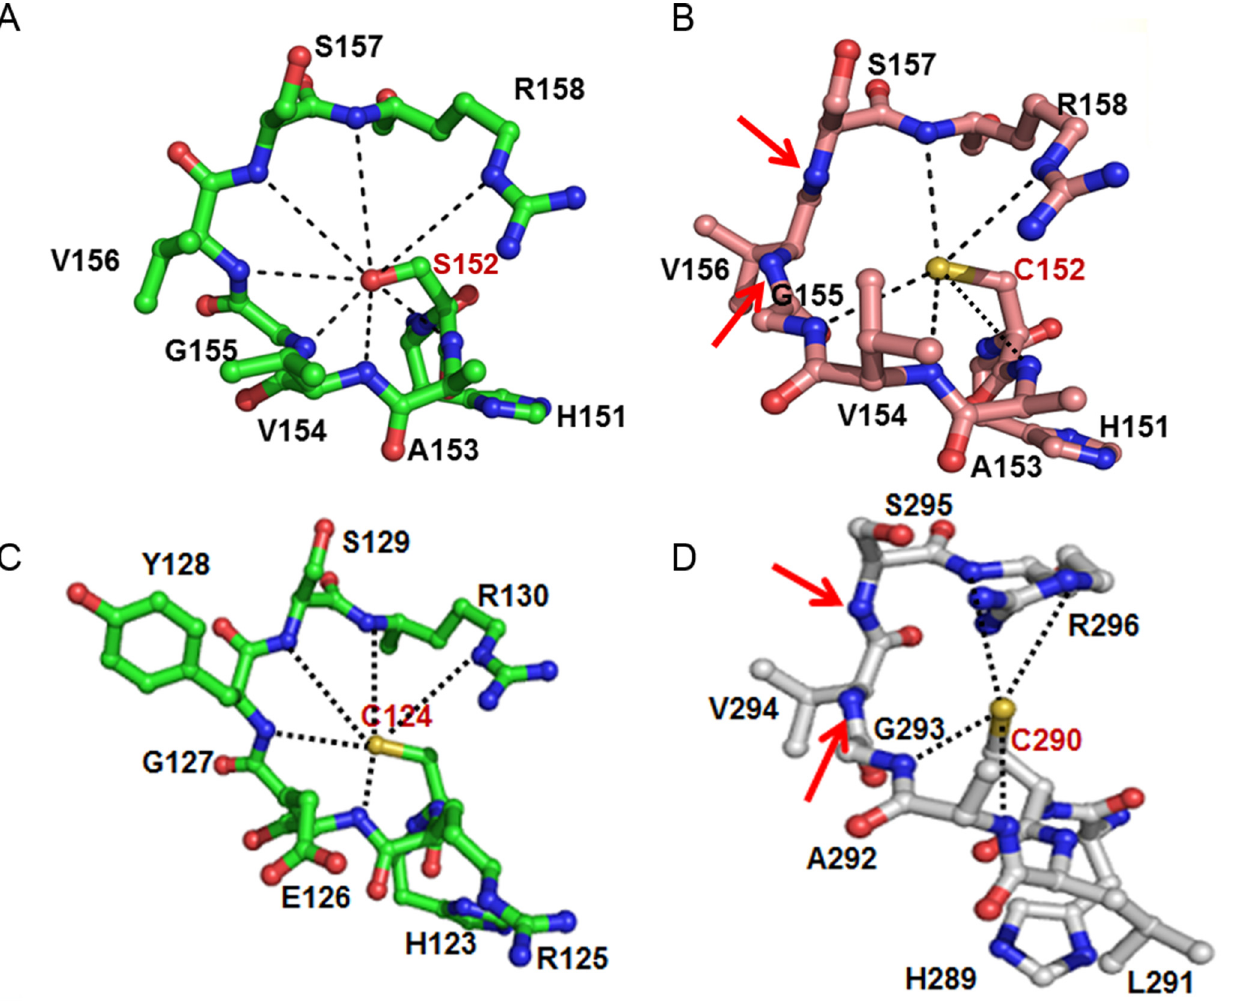
Fig 3. Comparison of the PTP-loop conformation between DUSP26-N (C152S) and other DUSPs. The PTP-loop conformation of DUSP26-N (C152S) (A), DUSP26-C (PDB code: 2E0T) (B), VHR (PDB code: 1VHR) (C), and MKP-4 (PDB code: 3LJ8) (D) are shown. The red arrows highlight the backbone amide atoms that are flipped away from the active